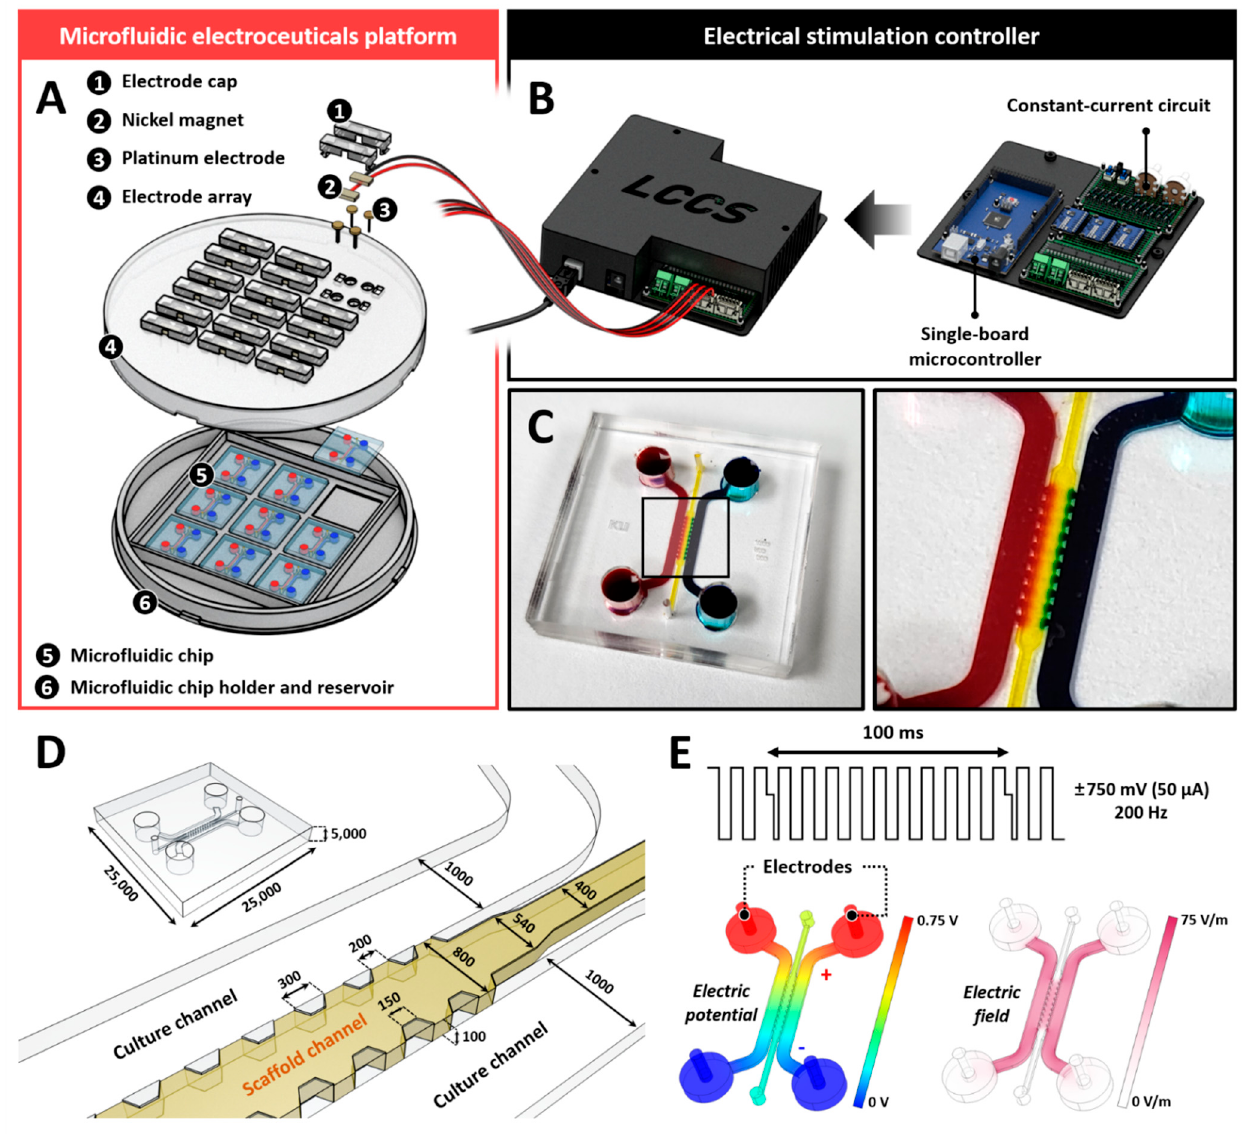
Figure 5. Microfluidic electroceuticals platform. ( A ) The microfluidic electroceuticals platform com- prises two major units: an electrical stimulation controller and a microfluidic chip array. ( B )